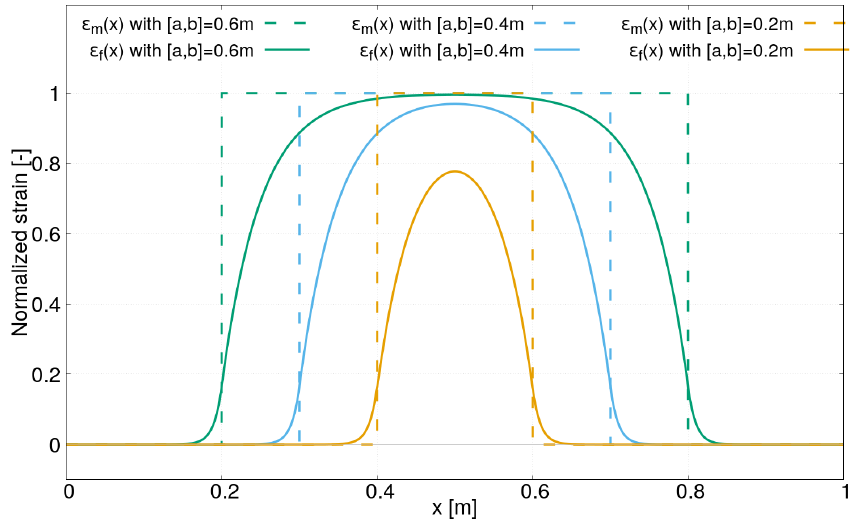
Figure 5. Strain profiles (cid:101) f ( x ) (with β 1 = 100 m − 1 and β 2 = 20 m − 1 ) under uniform fields (cid:101) m ( x ) of different